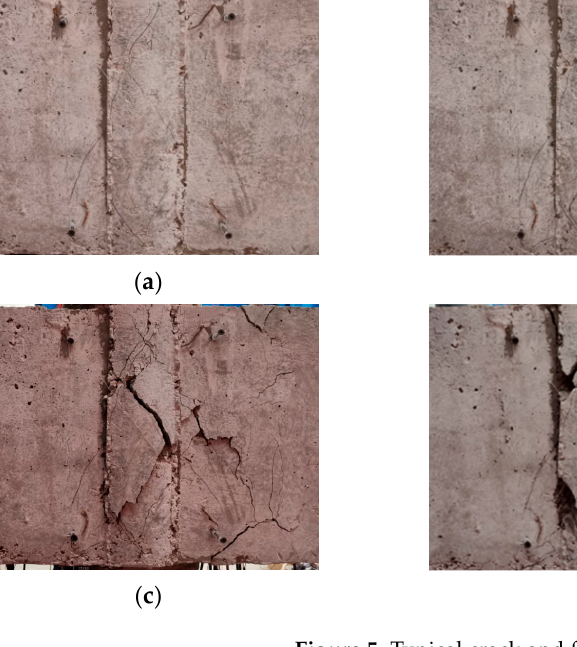
Figure 5. Typical crack and failure mode. ( a ) Oblique cracks. ( b ) Crossed oblique cracks. ( c ) Cracks extending. ( d ) Concrete spalling. ( e ) Overall failure mode.